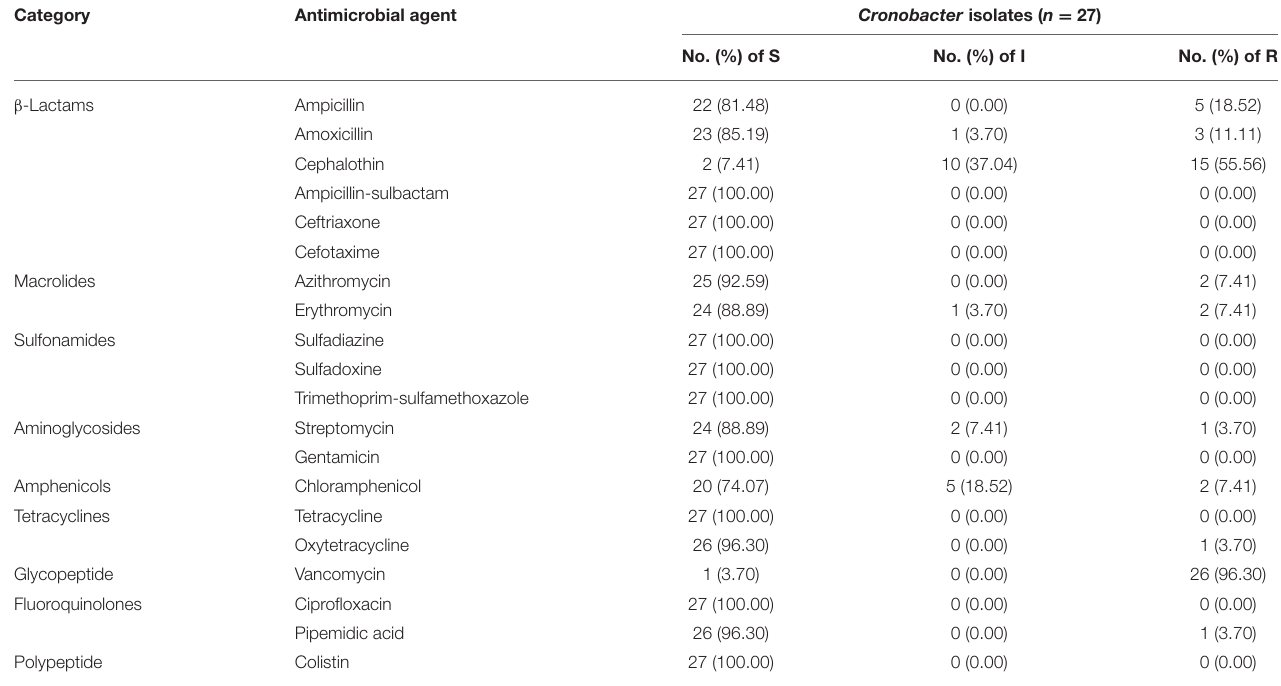
TABLE 3 | Antibiotic susceptibility of 27 Cronobacter isolates.